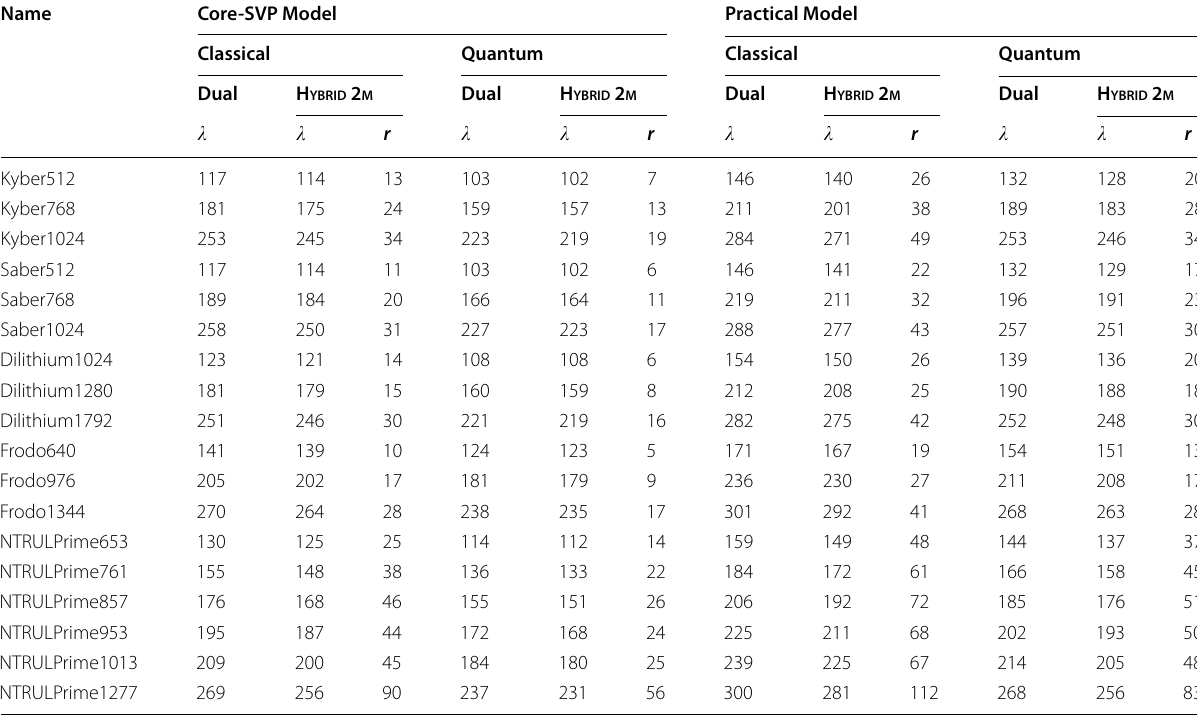
Table 11 Bit-security estimations under Assumption